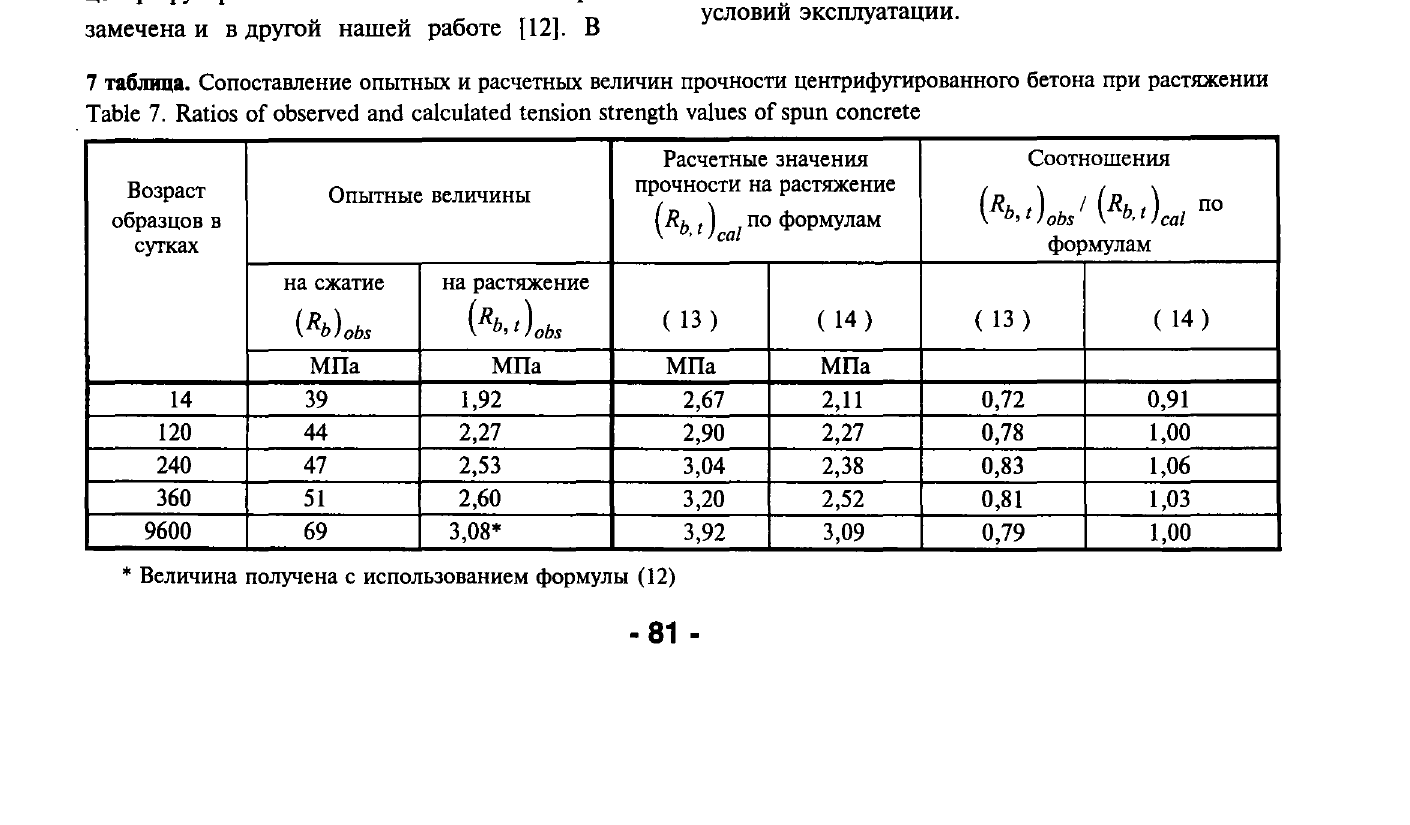
. Table 7. Ratios of observed and calculated tension strength values of spun concrete